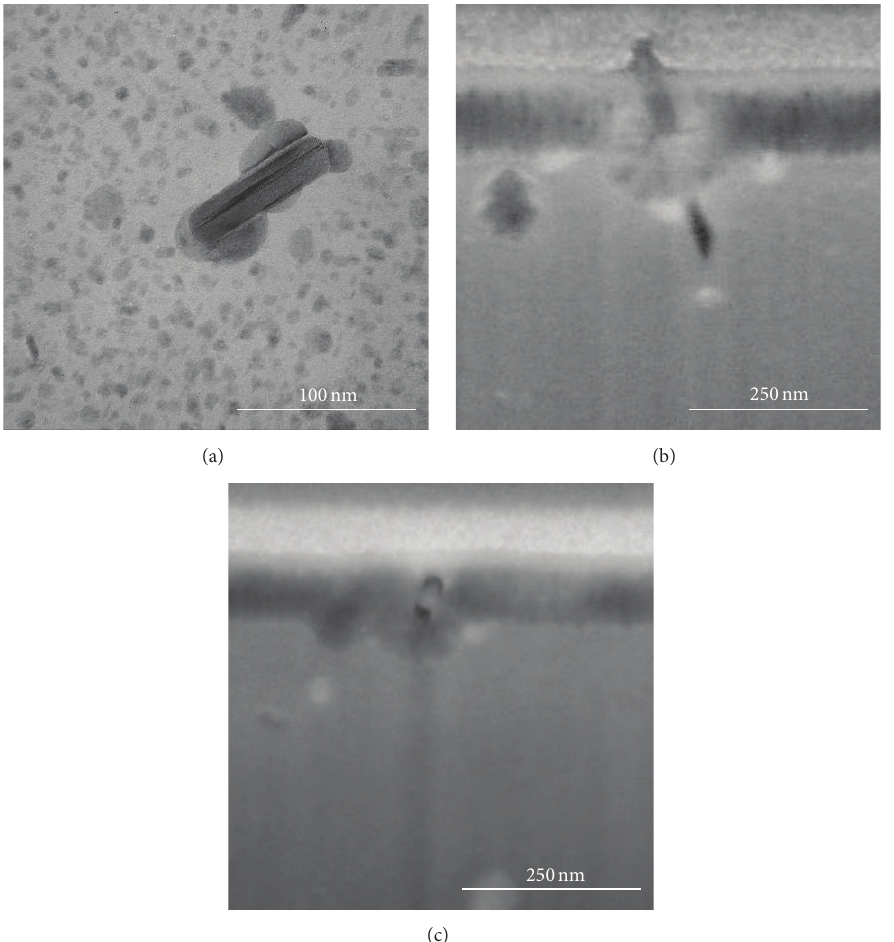
Figure 10: Comparison of a (a) coarsened MgZn 2 particle ( 𝜂 -phase) surrounded by Mg 2 Si or Mg 32 Zn 49 particles in the alloy EN AW- 7075 with the corresponding appearance in the AAO film on that alloy after anodisation at 3.8 V showing (b) dissolution of MgZn 2 and (c) transformation of Mg 2 Si to SiO 𝑥